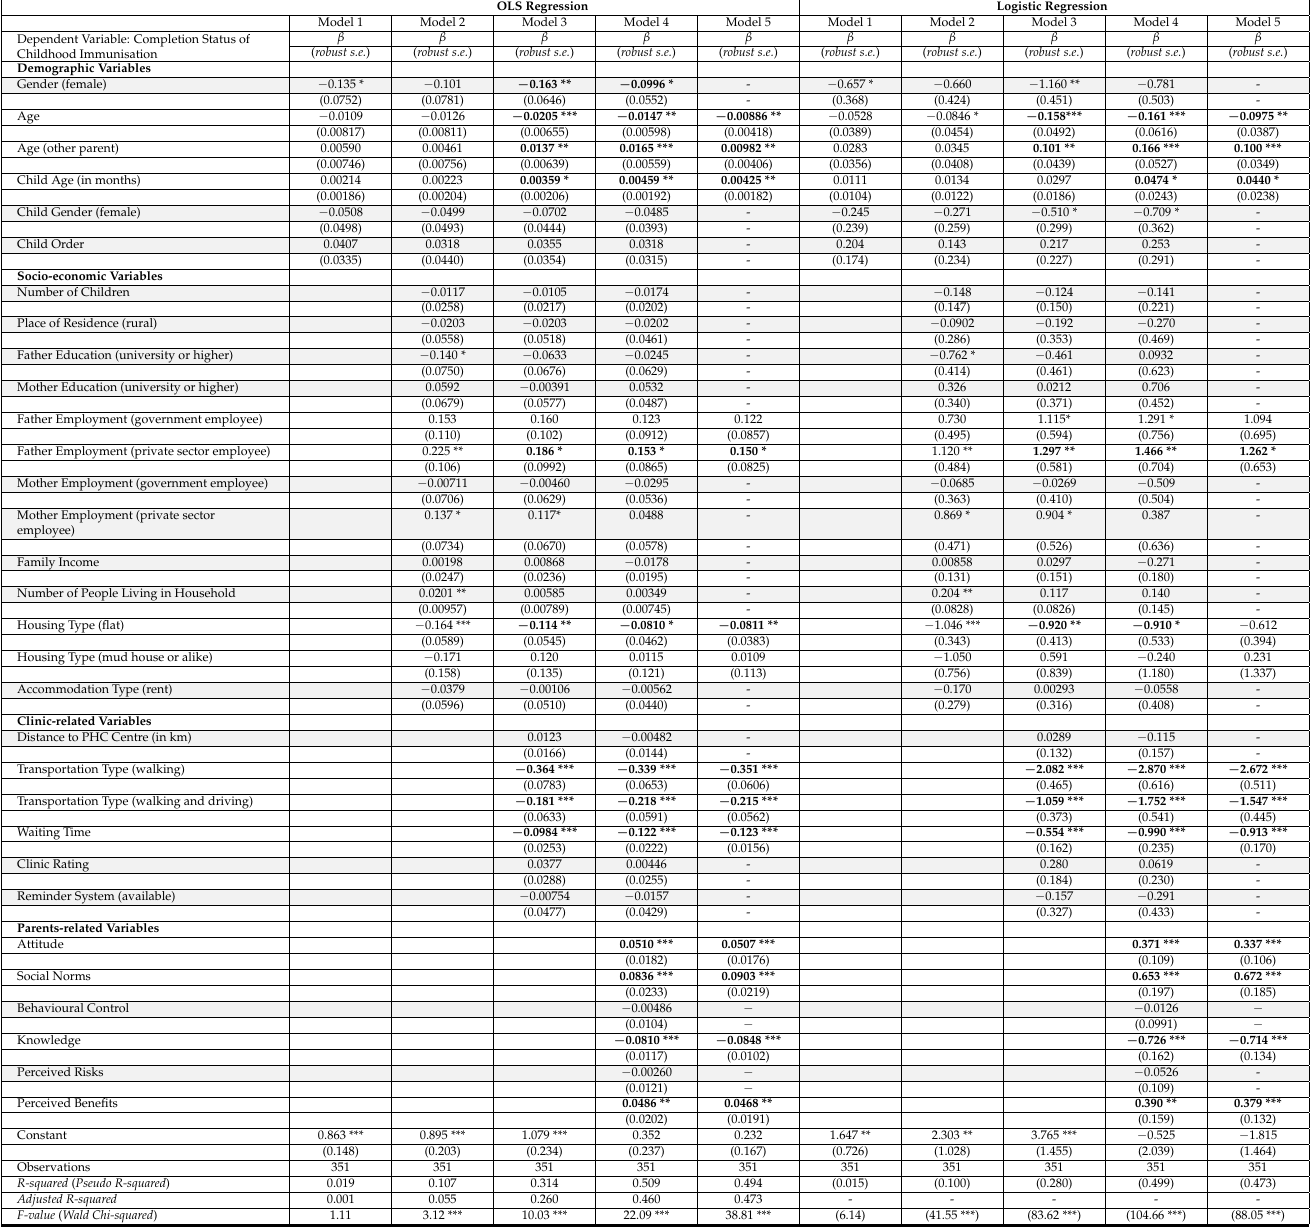
Table 6. OLS and Logistic Regression